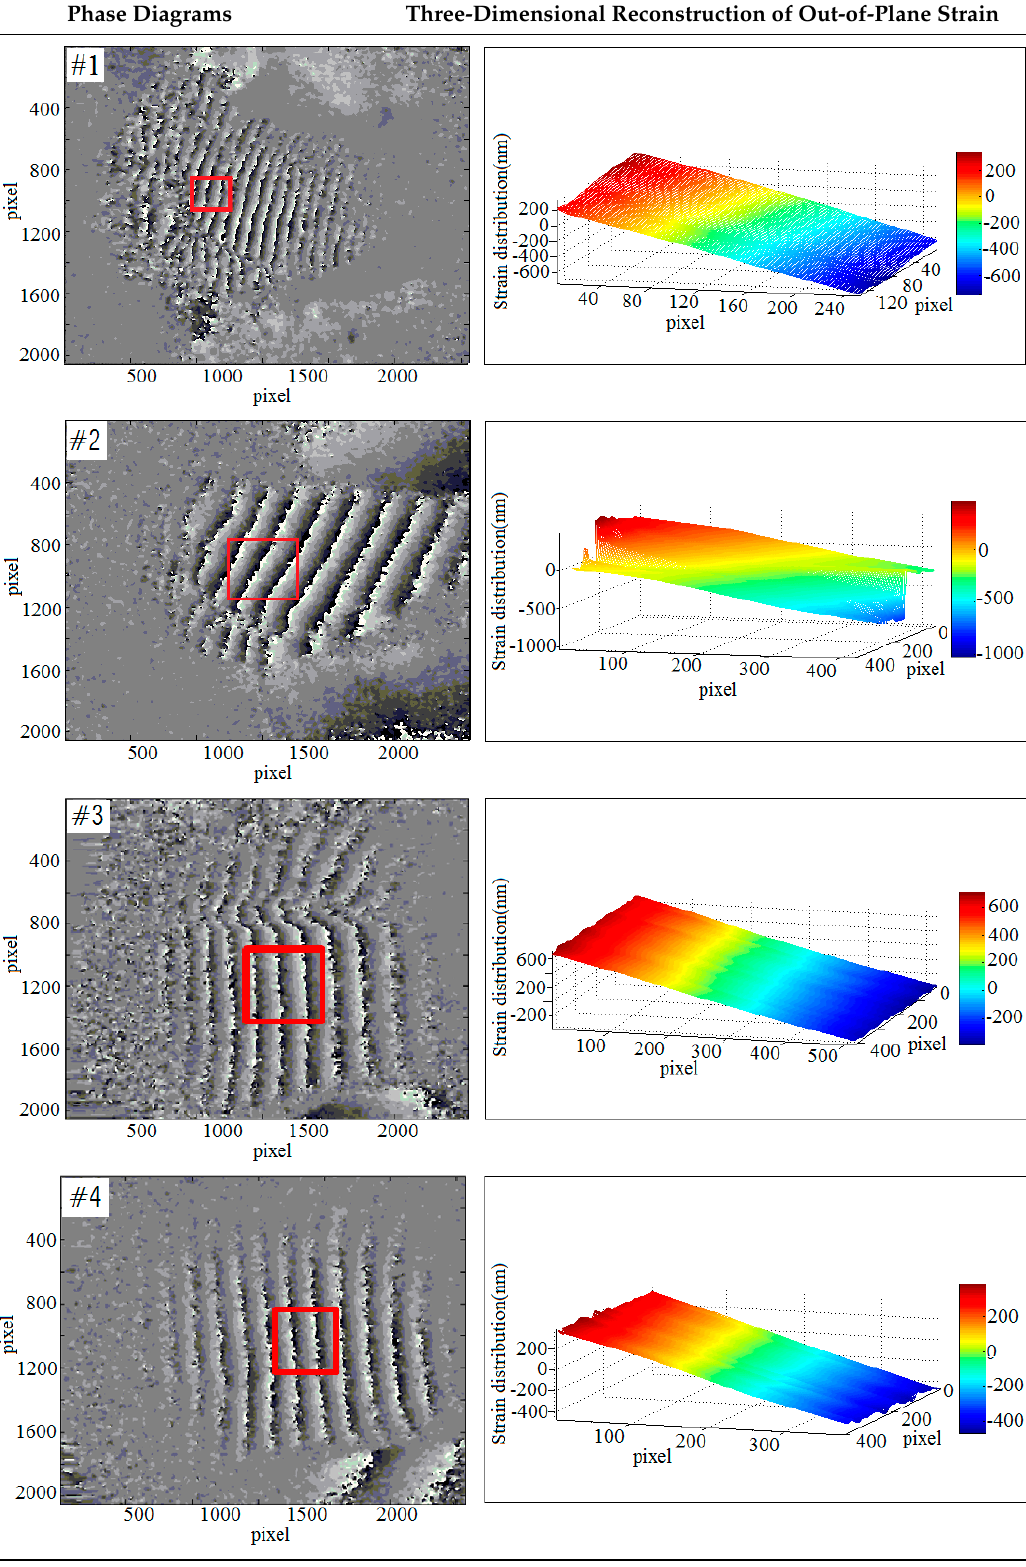
Table 1. The phase diagrams and strain diagrams.